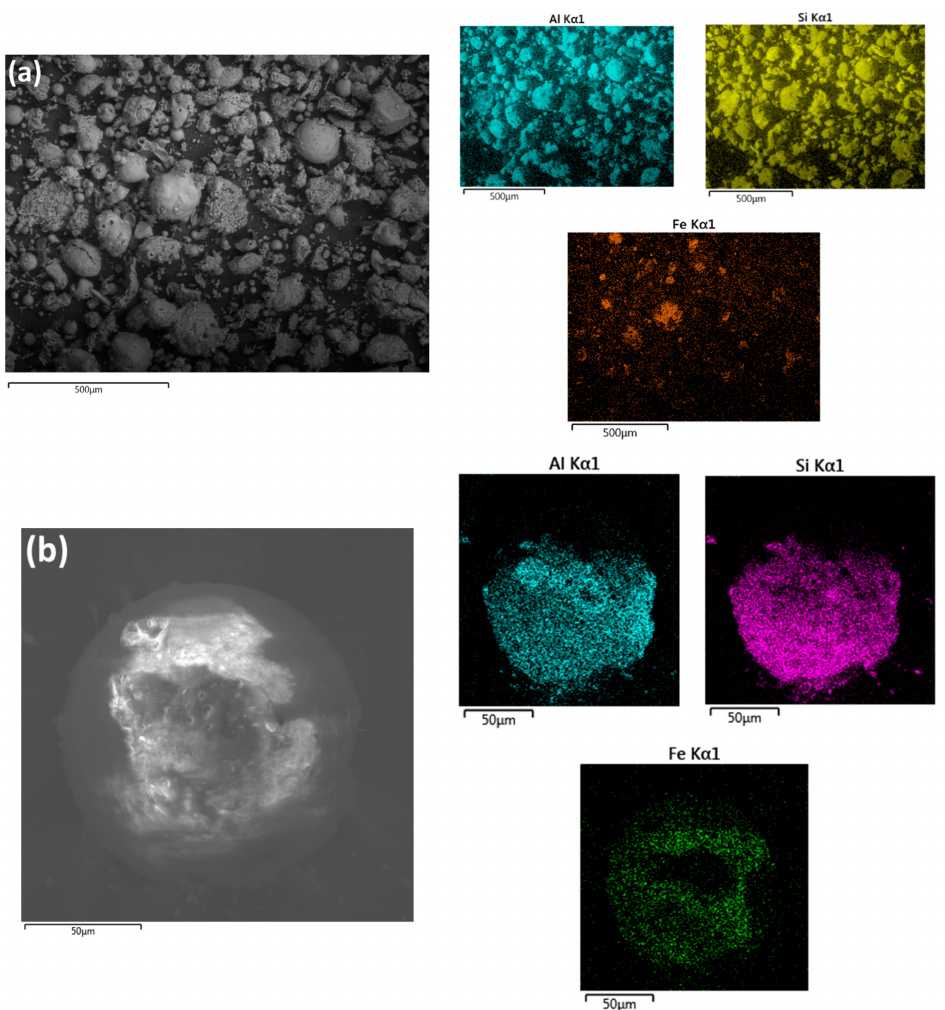
Figure 5. SEM images of the CFA samples: ( a ) particles of CFA after leaching by hydrochloric acid at T = 100 ◦ C, C HCl = 220 g/L, S:L = 1:10 and τ = 60 min (the mapping shows distribution of aluminum, silicon and iron), ( b ) spherical particle of CFA (the mapping shows distribution of aluminum, silicon and